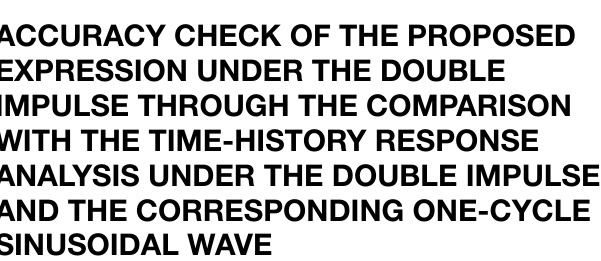
Frontiers in Built Environment |